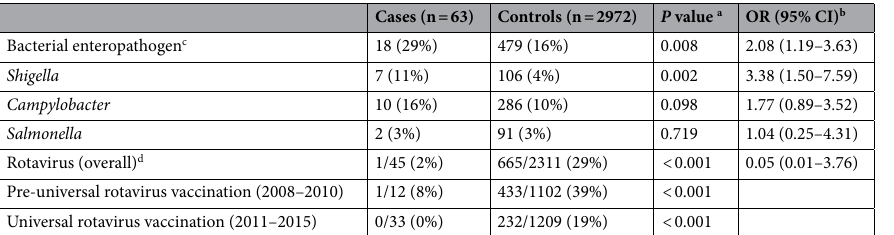
Table 2. Microbiologic results of children hospitalized for acute gastroenteritis with convulsions (cases) and without convulsions (controls). a P value was obtained by the chi square or Fisher’s exact test. b Odds ratio (OR) and 95% confidence intervals (CI) were obtained using bivariate logistic regression models, comparing children with the pathogen to those without the pathogen. c The detection of Shigella , Salmonella or Campylobacter spp. in stool culture. d Rotavirus was tested in 45 cases and 2311